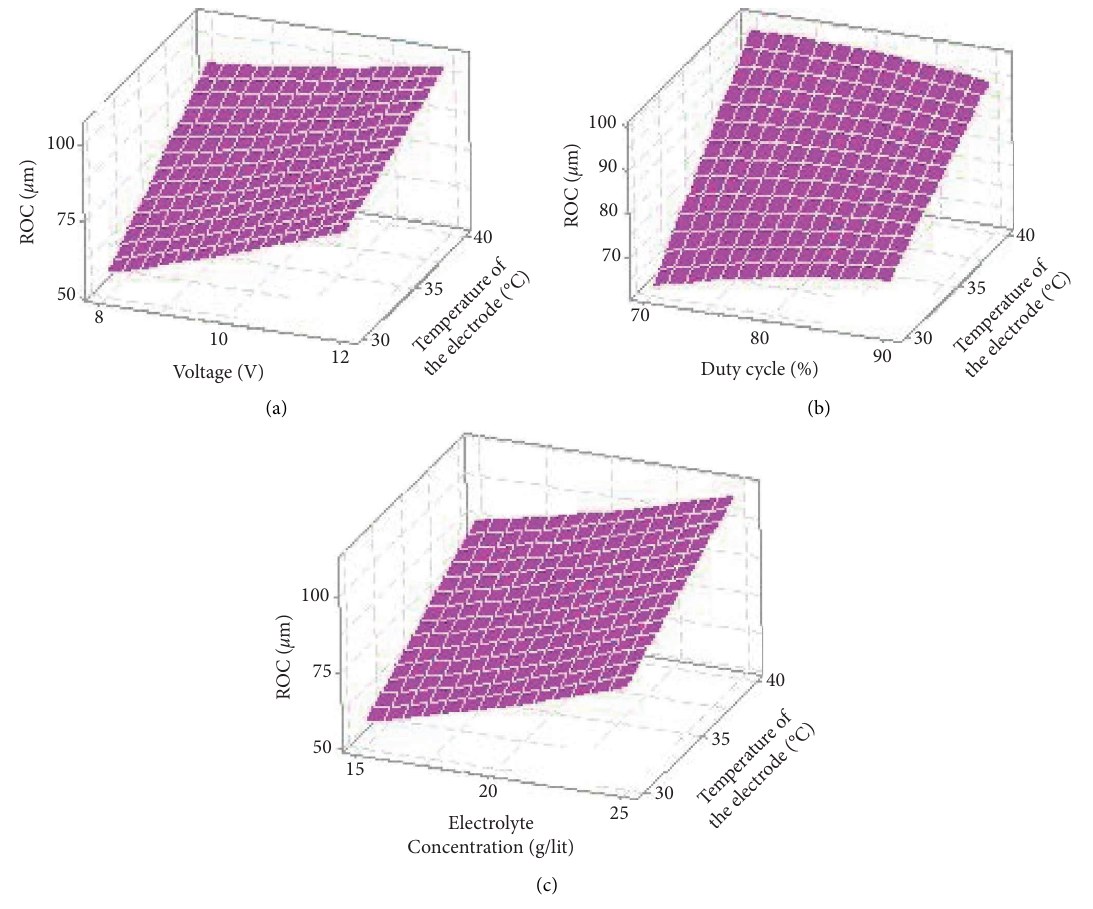
Figure 4: Process parameters efect on